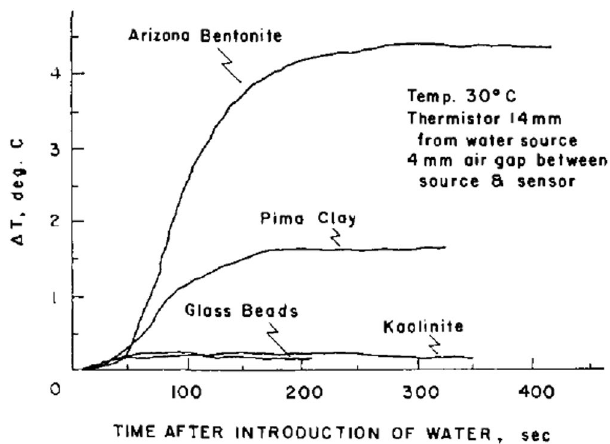
Figure 6. Rise of temperature in a region of soil separated from the water source by an air gap about 4 mm wide. That region was not accessible to the vapor only and not to the liquid water (from Anderson and Linville) 6